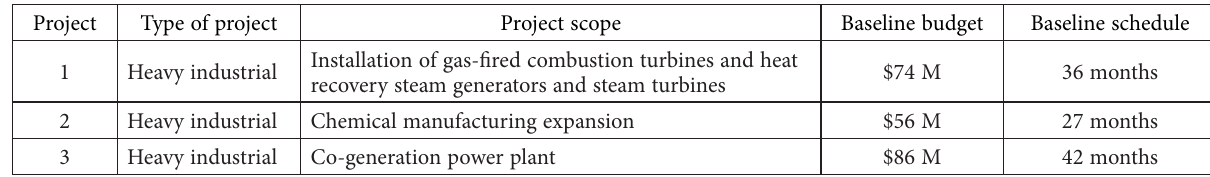
Table 6. Breakdown of information of three case study projects used for implementation and analysis of results